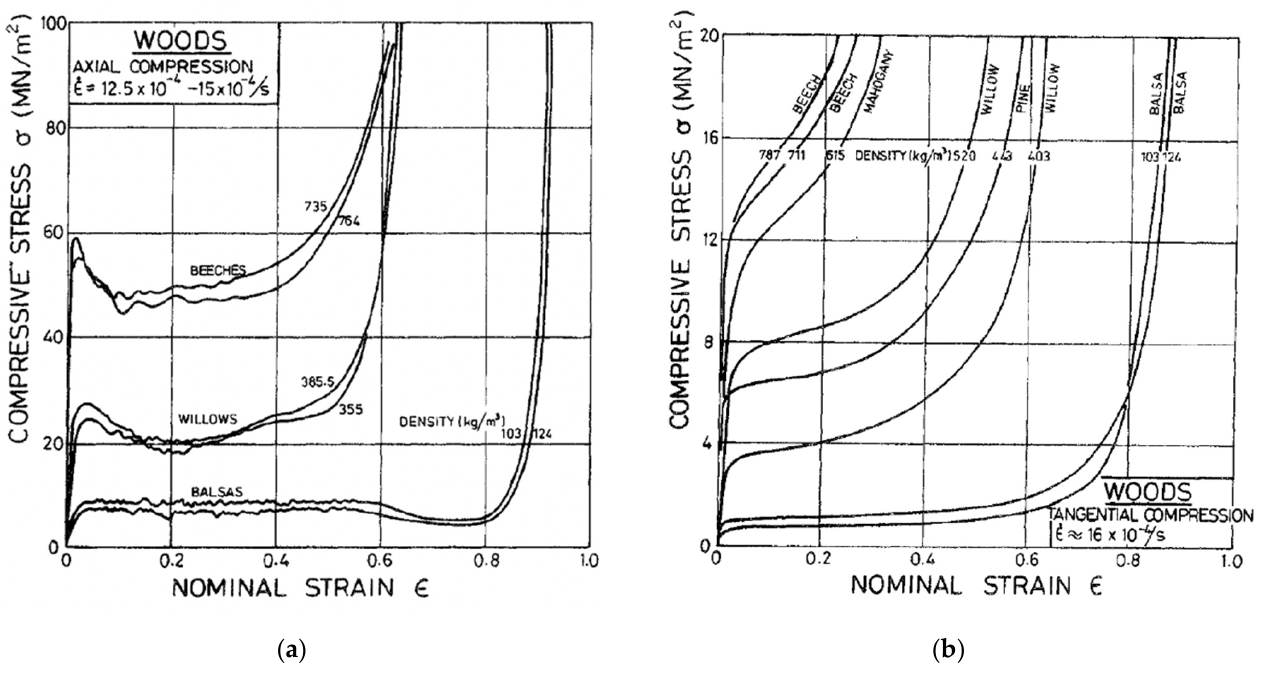
Figure 8. Experimental compressive stress–strain plots of a number of different woods measured using specimens ( a ) cut parallel to the axis of the trunk of the tree and ( b ) cut at a tangent to the trunk. From [4].